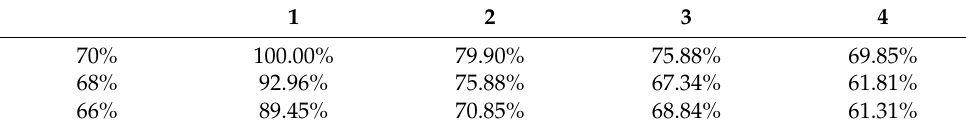
Table 5. Strength reduction coefficient results of backfill.